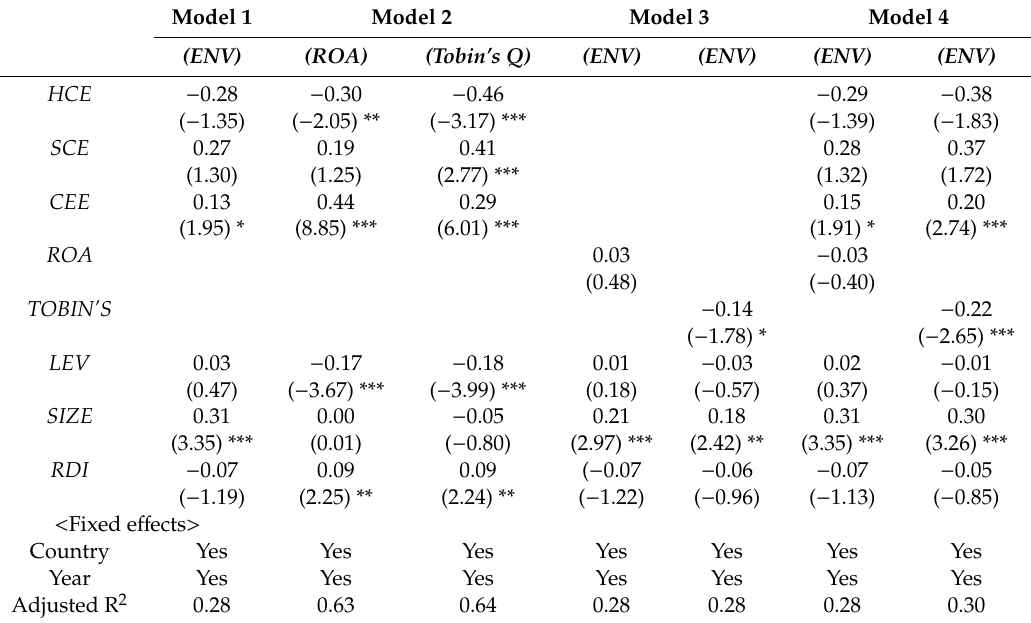
Table 3. Mediating e ff ect of financial performance (IC and